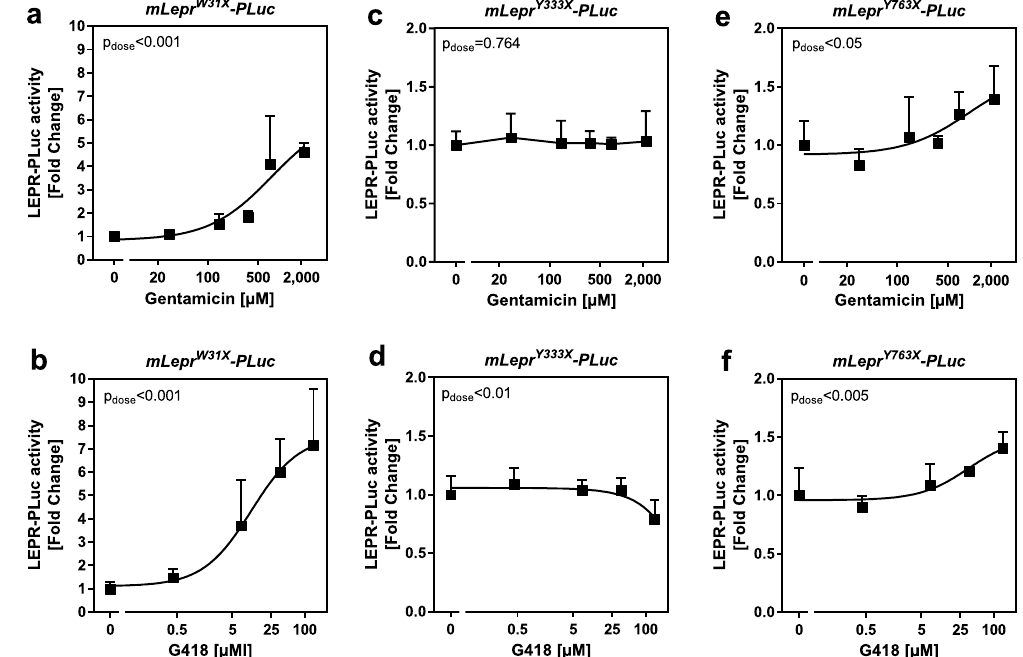
Figure 1. Susceptibility of nonsense mutated Lepr - PLuc fusion constructs to aminoglycoside mediated read- through. HEK293 cells were co-transfected with either ( a , b ) mLepr W31X - PLuc , ( c , d ) mLepr X333Y - PLuc or ( e , f ) mLepr X763Y - PLuc and phRG-b for data normalization. The indicated nonsense mutations were imbedded into ± 6 bp murine receptor context (see Table 1 and Supplementary Fig. 1). Two days after the transfection, cells were treated for 24 h with rising concentrations of either G418 or gentamicin (n = 4–6, SD).